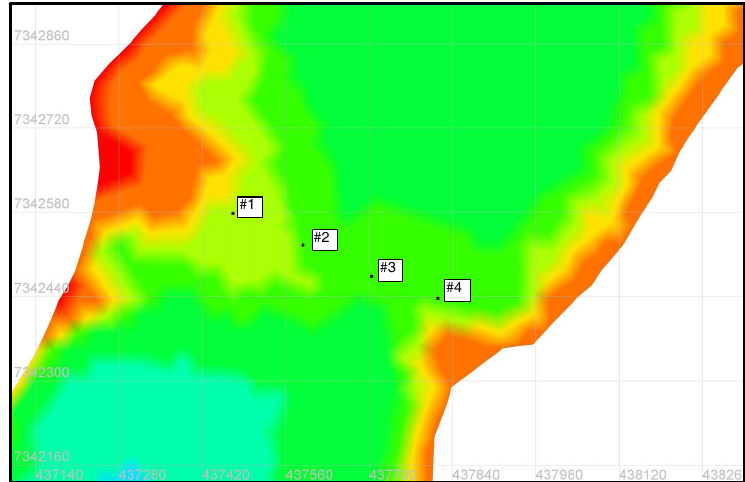
Figure 12. The four selected points that were chosen for quantifying the effect of different velocities in a